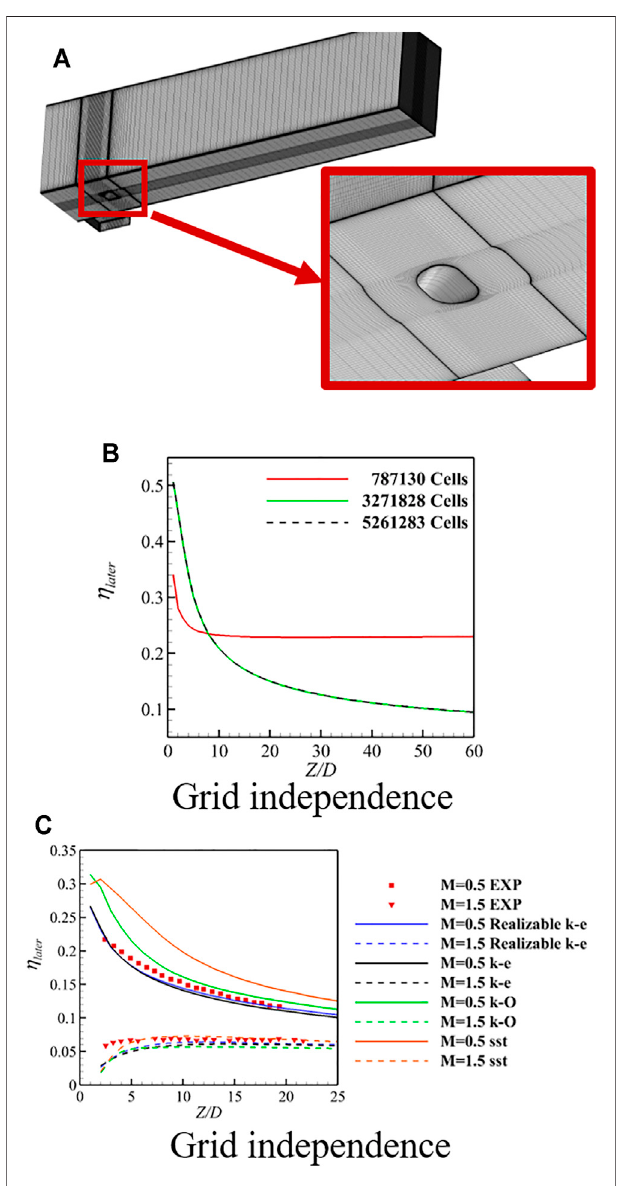
FIGURE 2 | Grid and method information. (A) Computational grids, (B) grid independence, and (C) numerical veri fi cation.